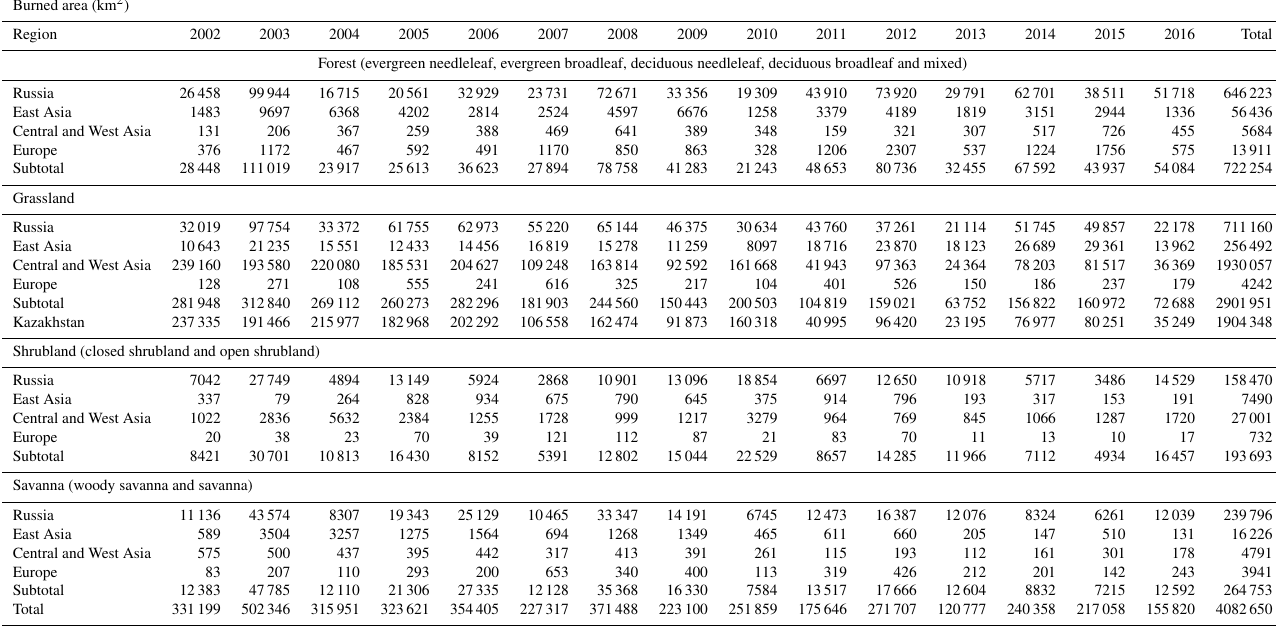
Table 1. The area burned in forest, grassland, shrubland and savanna in geographic regions from 2002 to 2016. The data of the area burned in Kazakhstan are listed for comparison only and are not included in the tabulation.